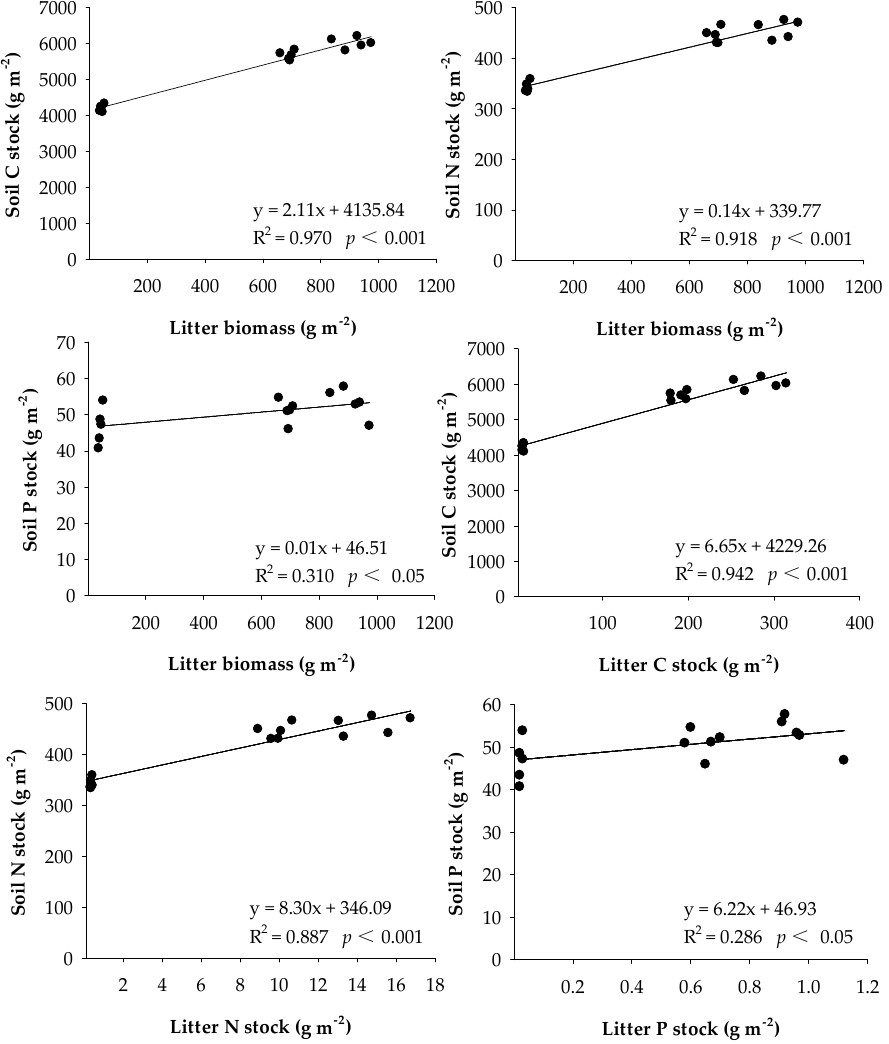
Figure 5. Relationships between soil nutrient stocks and litter properties.